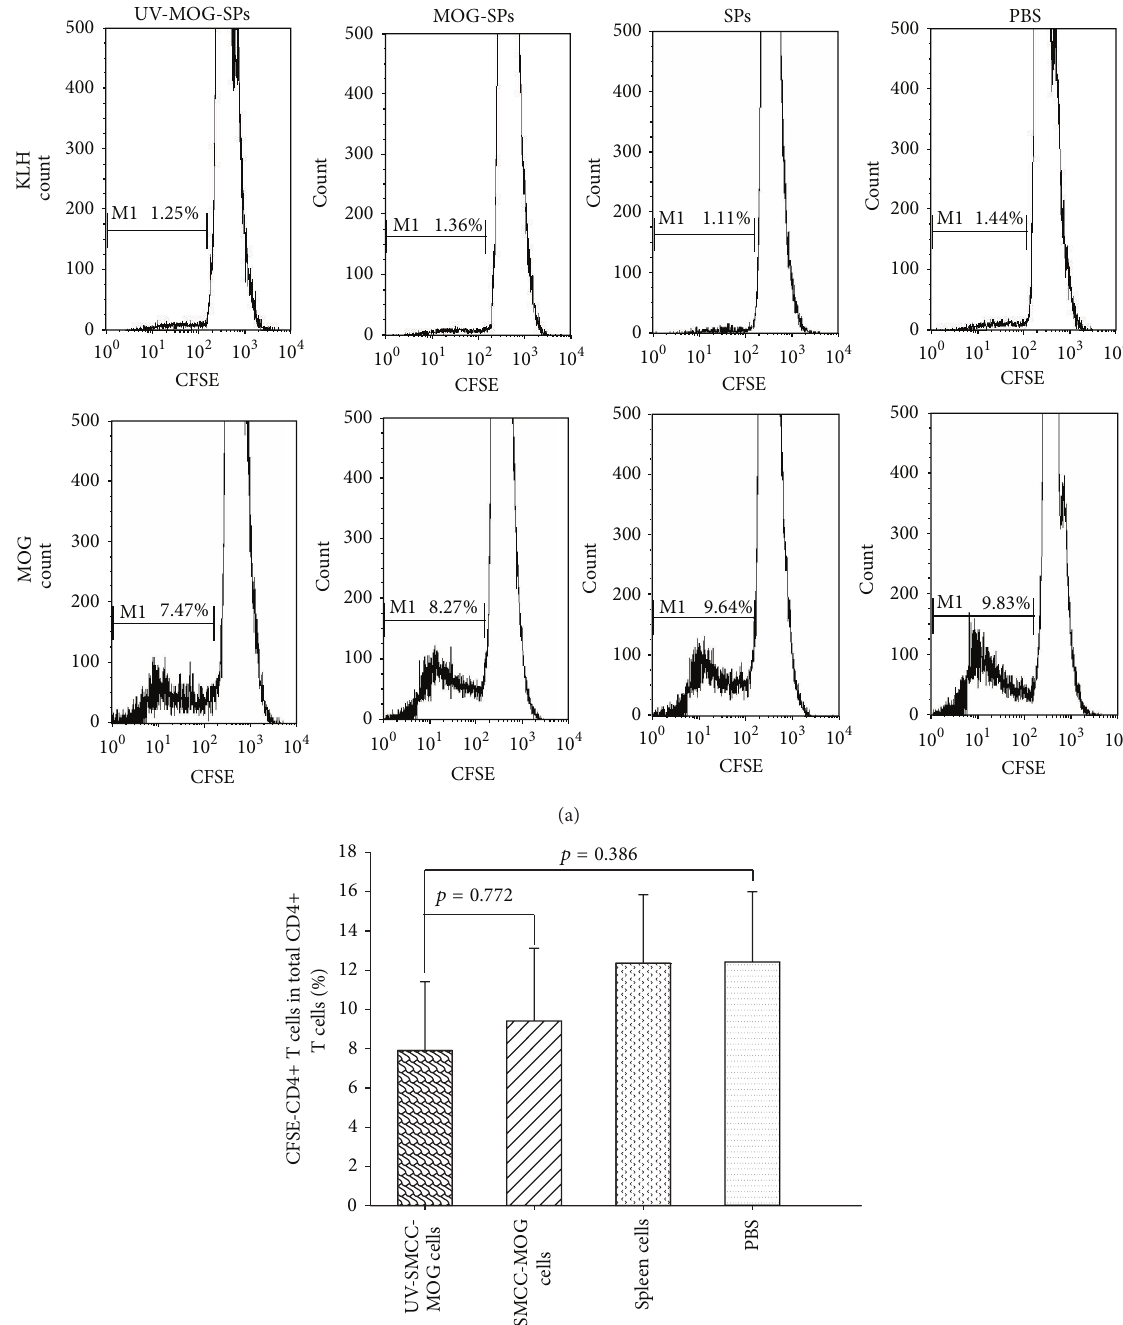
Figure 5: MOG-coupled spleen cells treatment induces similar MOG-specific CD4+ T cell proliferation in all groups. Spleen cells from each group in Figure 3 were labeled with CFSE; then CFSE-labeled spleen cells (5 × 10 5 /well) were stimulated with MOG 35 unrelated antigen KLH (10 𝜇 g/mL) for 4 days. Thereafter, the cells were harvested and stained with anti-CD4-PerCp. CD4+ T cell proliferation (dilution of CFSE) was examined by flow cytometry by gating CD4+ T cells. (a) The flow cytometric data on proliferating CD4+ T cells/total CD4+ T cells (%) from one representative animal of each group were shown. (b) The data on proliferating CD4+ T cells with CFSE dilution in all CFSE-labeled CD4+ T cells from all animals (10 mice/group) were summarized. Statistical analysis results were depicted in the figures. Similar data were obtained from two additional independent